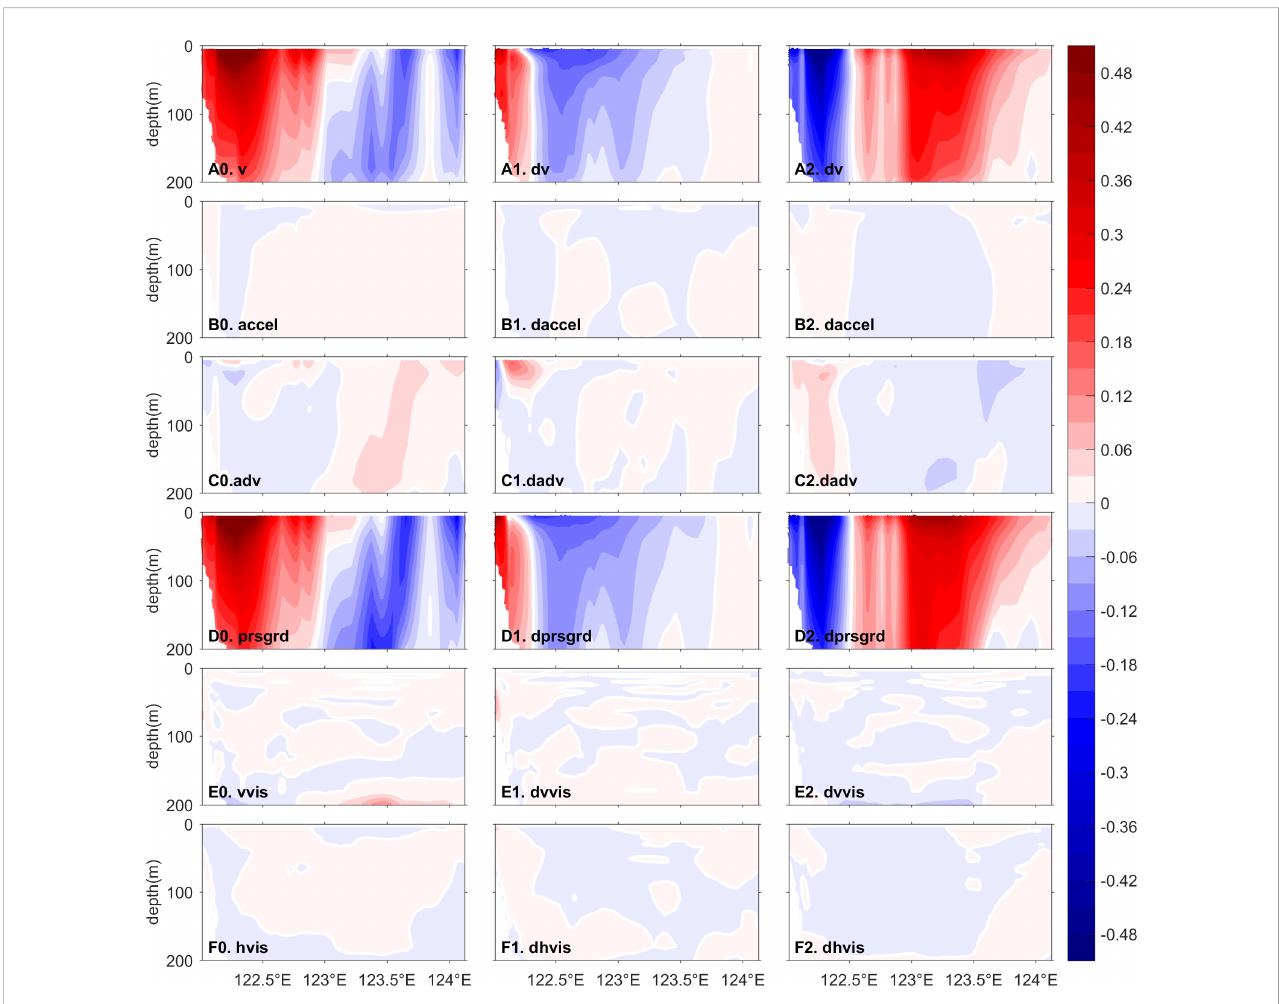
FIGURE 8 The cross-shelf velocity along the 200 m isobaths at t=30 days and its contributions to the cross-shelf velocity in the (A0-F0) Ctrl experiment and their variations under the effect of (A1-F1) cyclonic and (A2-F2) anticyclonic eddies (m/s). The cross-shelf velocity and contributions are the terms in momentum balance equation